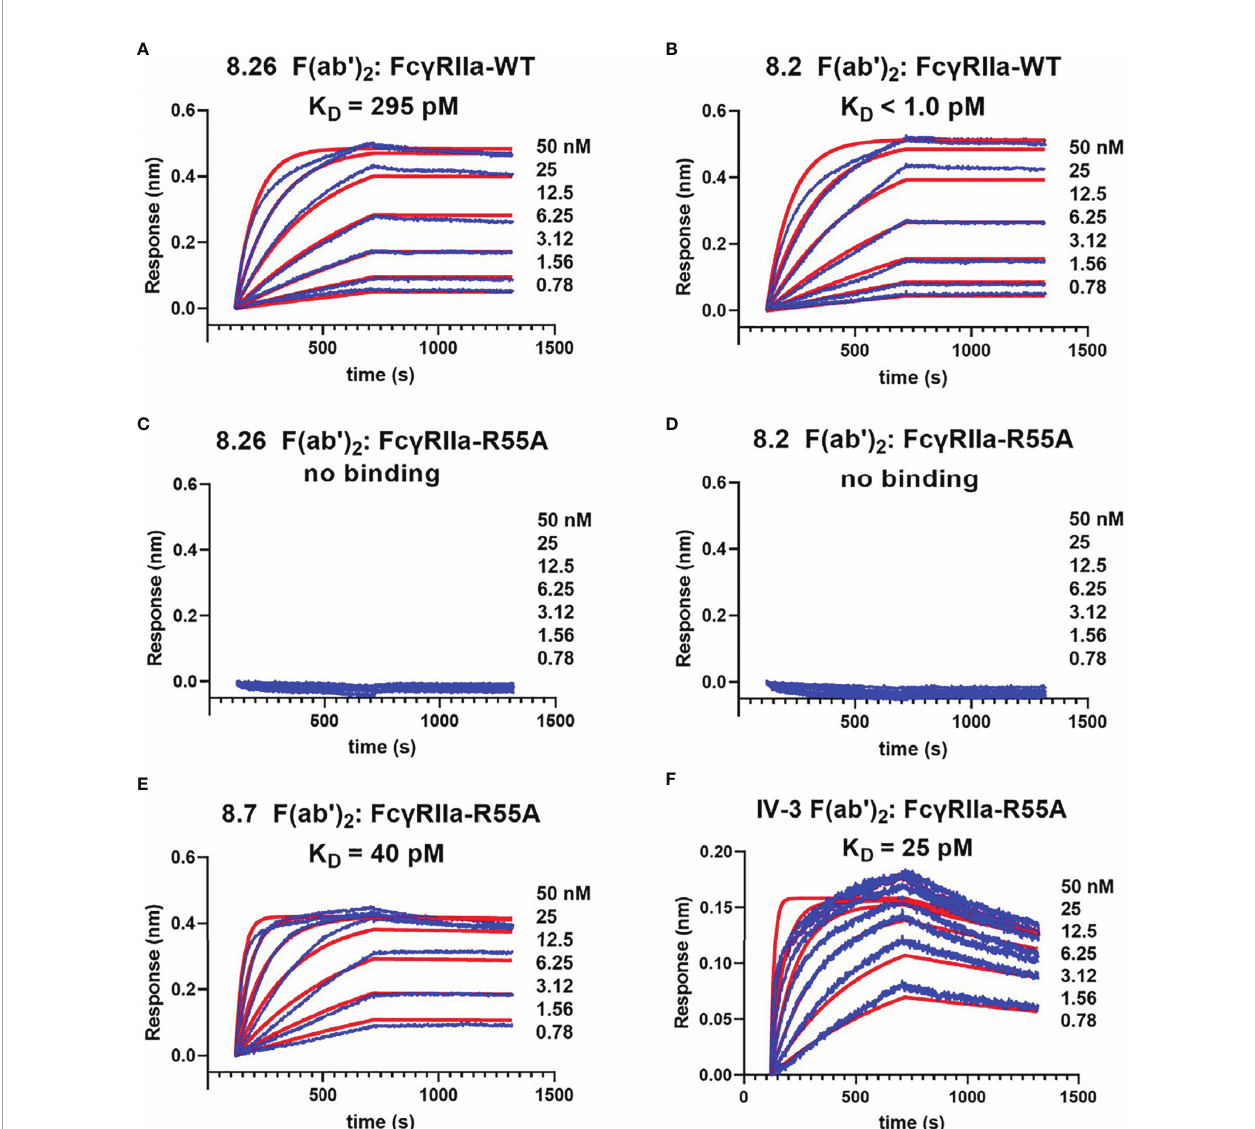
to abrogating Fc binding ( Figure 2A ), also partially disrupts the epitope of mAb 8.7 but not that of mAb IV-3 ( Figures 2B , c.f. C ). Similarly, fl ow cytometric analysis indicated the R55A mutation in domain 1 of Fc g RIIa abrogated mAb 8.2 Fab binding ( Figure 2D ), despite the overall similar expression of the mutant receptors indicated by the equivalent binding of the F(ab ’ ) 2 fragments of mAbs IV-3 to all mutant receptors ( Figure 2 and Supplementary Figure 2 ). The R55A mutation is distant from the Fc ligand binding site in the second ectodomain and, as expected, did not affect the binding of IgG IC ( Supplementary Figure 3